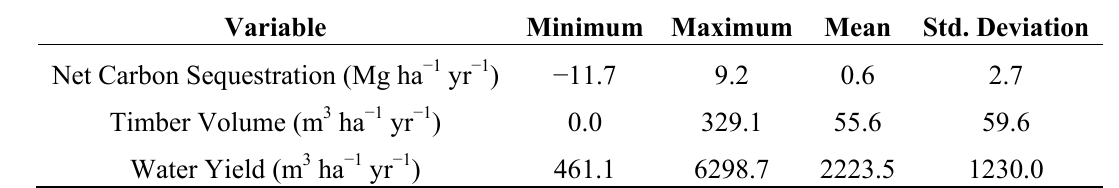
Table 2. Descriptive statistics for three ecosystem services and drivers for Florida Pinus elliotti stands.